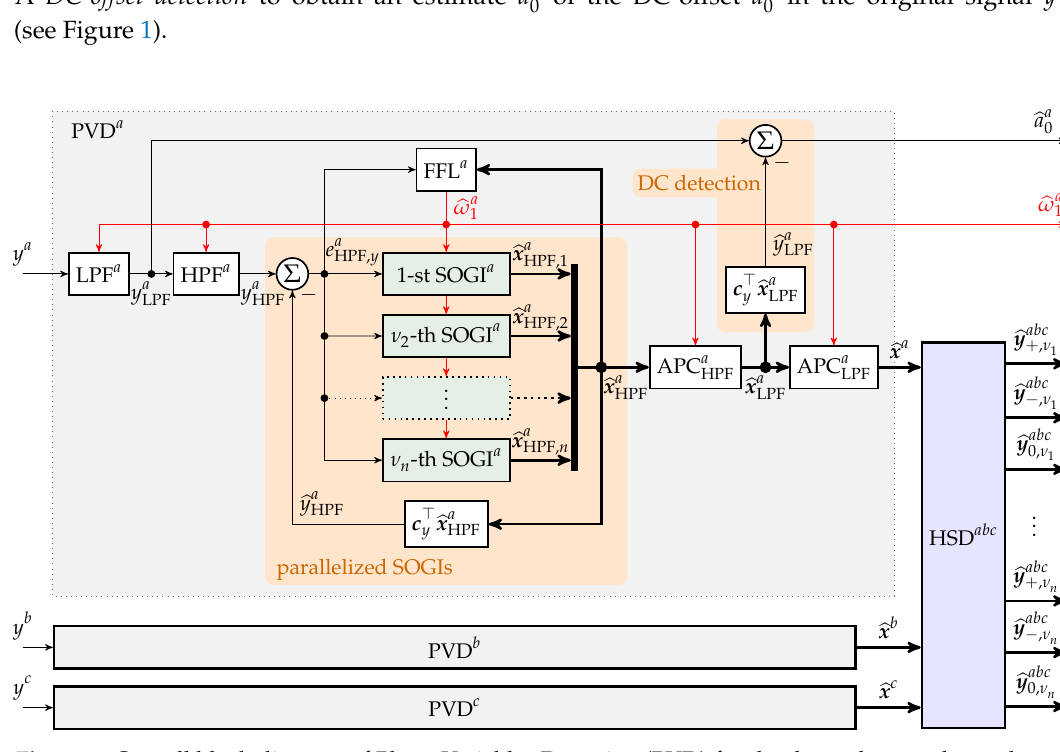
Figure 1. Overall block diagram of Phase Variables Detection (PVD) for the three phases a , b , c and Harmonic Sequence Detection